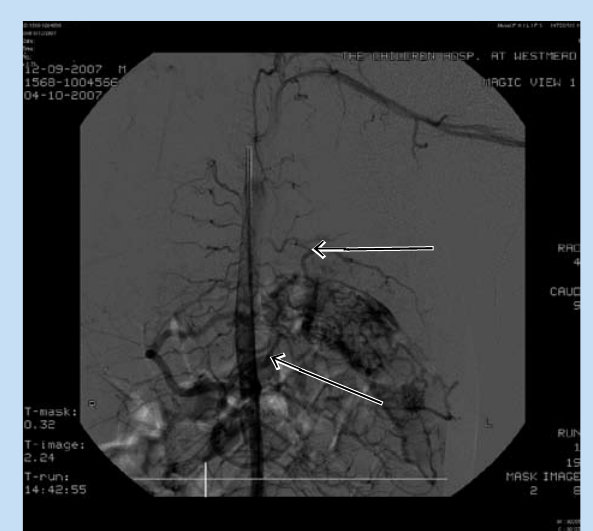
Fig. 6. Coronal MRI image, four months after intervention and surgery, demonstrating no residual malformation and near-normal